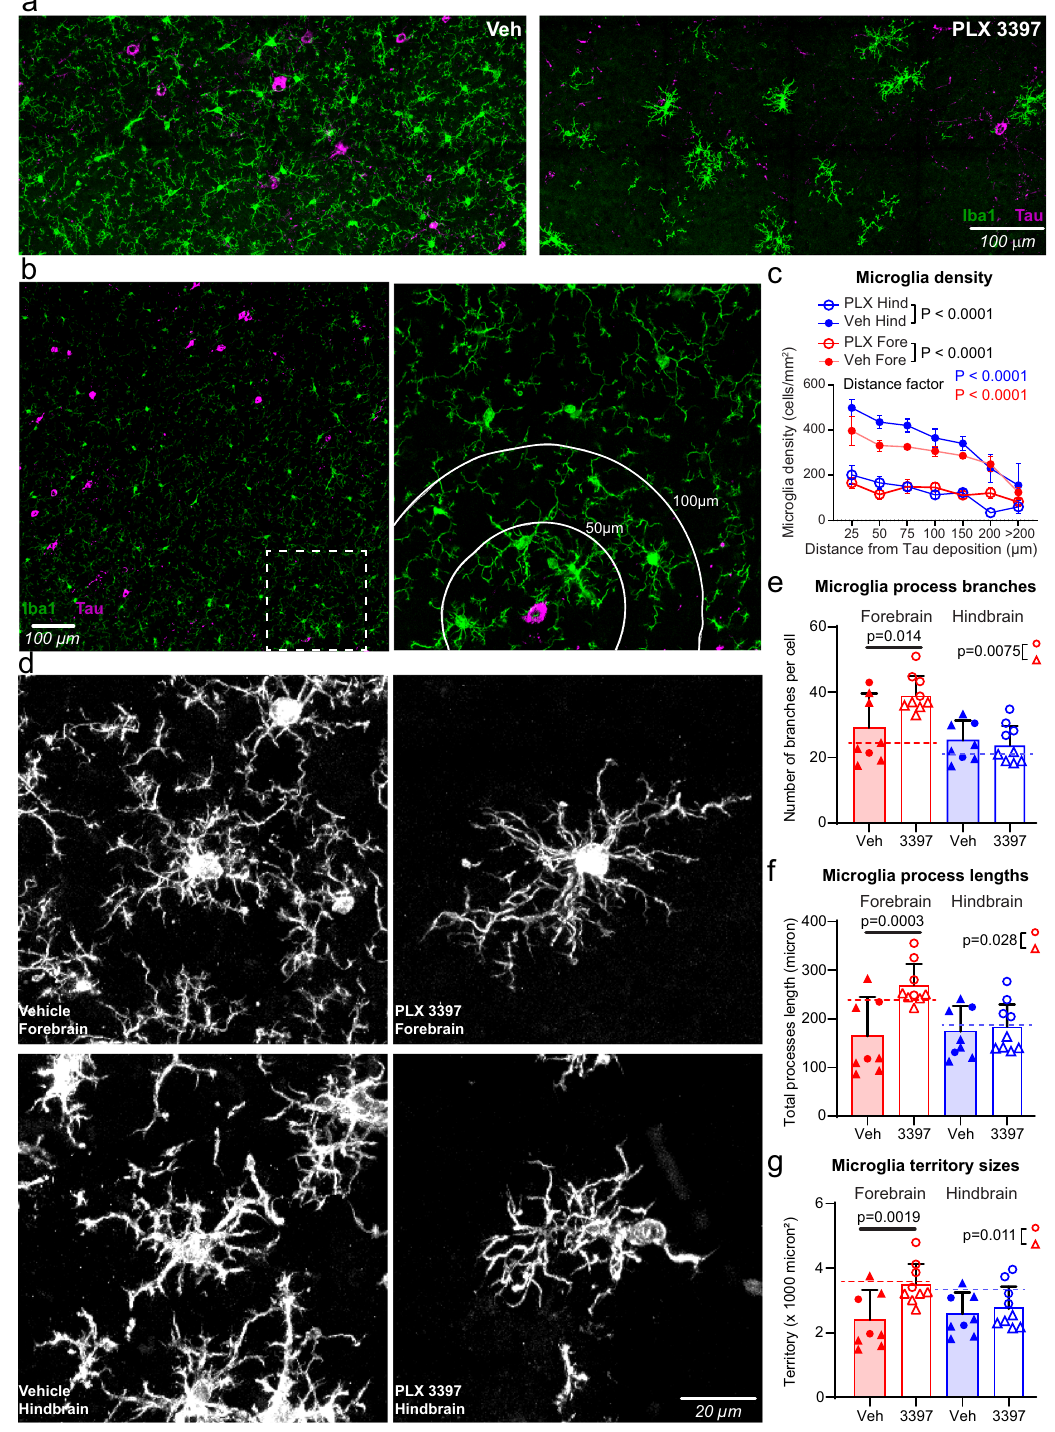
Fig. 9 | PLX3397 treatmentpreferentially eliminatesreactive microglia around tau deposits. a Representative confocal images of immunostaining of tau protein (magenta) and microglia (Iba1, green) in the brain of a vehicle-treated (left) or PLX3397-treated (right) 210-d-old Tg2541 mouse. b Representative confocal ima- ges,similartopanela,ofavehicle-treated210-d-oldTg2541mouse.Therightpanel shows the zoomed image from the dashed box in the left panel. The white lines in the right panel show distances from the tau deposit at the center. c Quanti fi cation ofmicroglialdensitiesatdifferentdistancesfromthenearesttaudepositinTg2541 mice treated with vehicle or PLX3397 (275mg/kg oral). Data are presented as mean±S.E.M. Two-way ANOVA was used to compare statistical differences between treatment groups and distance bins. d Representative confocal images of